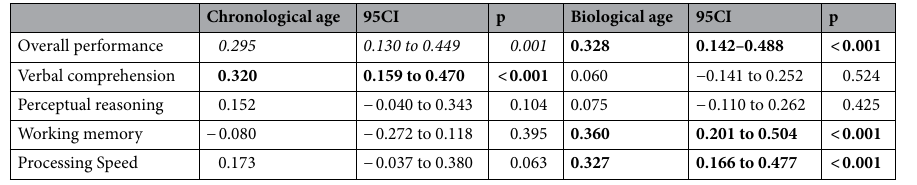
Table 1. Partial correlations between chronological/biological age and WISC-IV overall performance, and performance on the four factors. Italicised values: p < 0.01, Bold values: p < 0.001. Partial correlations between chronological age/biological age and WISC-IV broad abilities and overall performance. The correlations represent the independent effect of chronological age and biological age, with the effect of the other kind of age controlled for. 95CI = 95% confidence